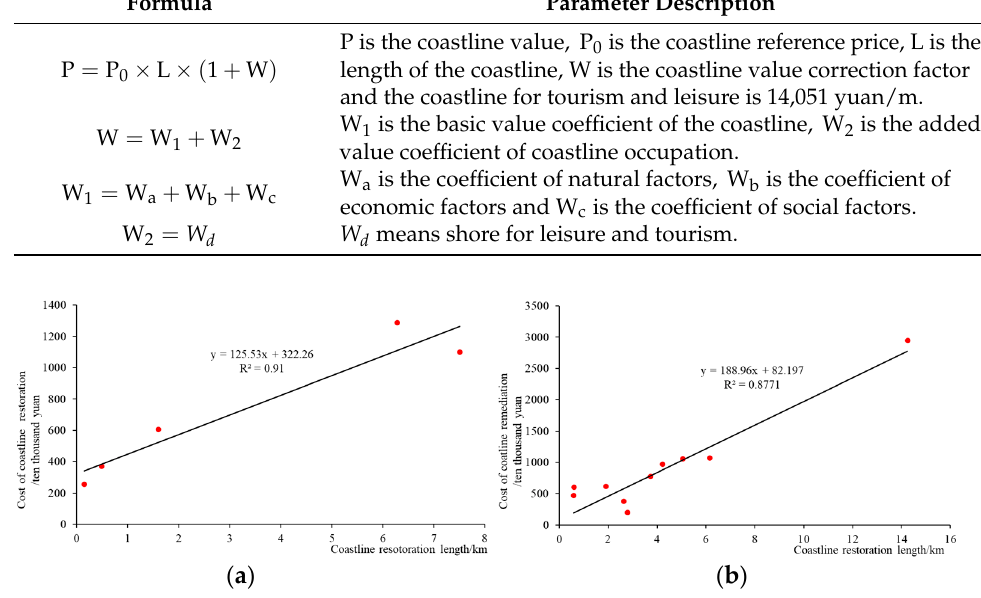
Figure A1. The correlation scatter plot of coastline restoration length and aggregate investment. ( a ) Relationship between the length of sandy coastline restoration and aggregate investment; ( b ) Rela- tionship between the length of silt coastline restoration and aggregate investment (Data sources are in Table A1).